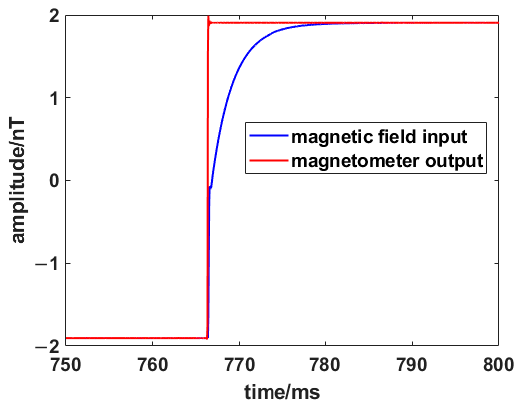
Figure 13. Magnetometer input and output of the rising edge of the square wave.